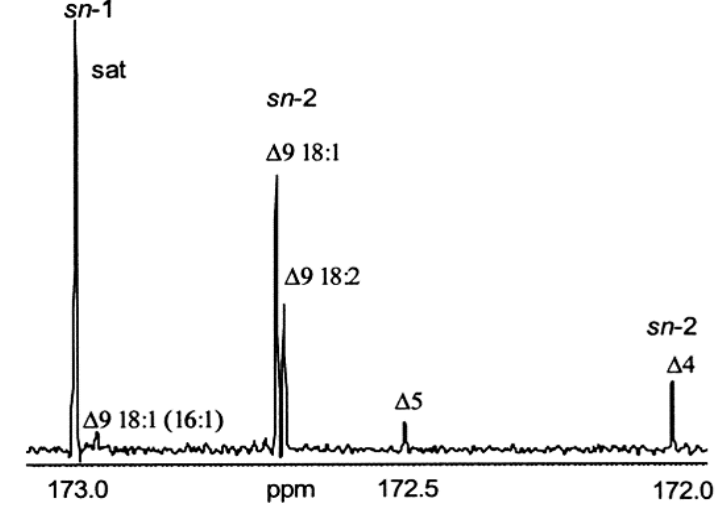
Figure 9. 13 C-NMR of the carbonyl region of docosahexaenoic acid-enriched egg yolk phosphatidylcholine. Adopted, with permission, from [21]. Copyright 2001, Wiley-VCH. Adopted, with permission, from [21]. Copyright 2001,